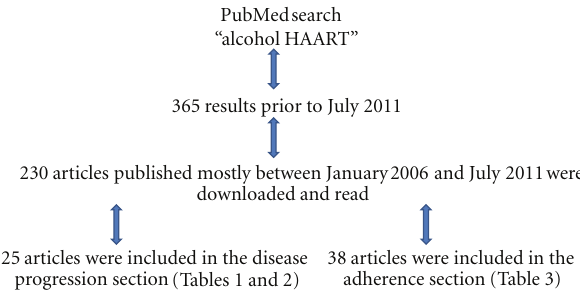
Figure 1: Methods used for literature